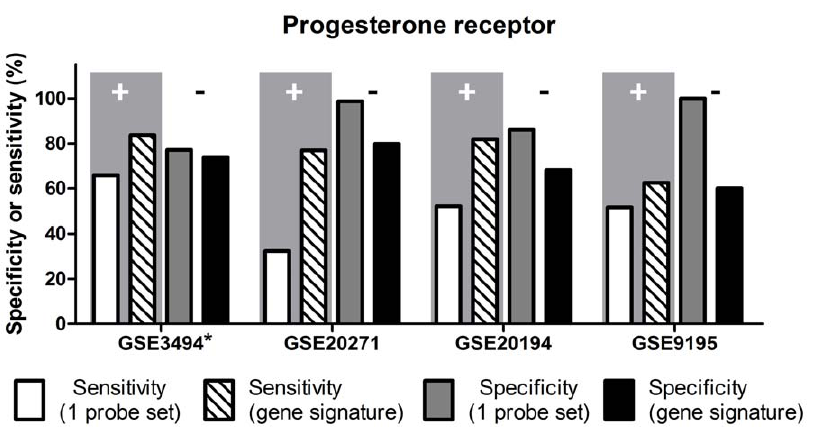
Figure 6. PR status determination: sensitivity (‘ + ’) and specificity (‘-’) obtained with two different microarray-based methods. The improved feature is highlighted by gray background. Datasets GSE3494, GSE20271 and GSE20194 were profiled on HG-U133A GeneChips; GSE9195 was profiled on HG-U133 Plus 2.0GeneChips. * Training set. doi:10.1371/journal.pone.0026023.g006 PLoS ONE |